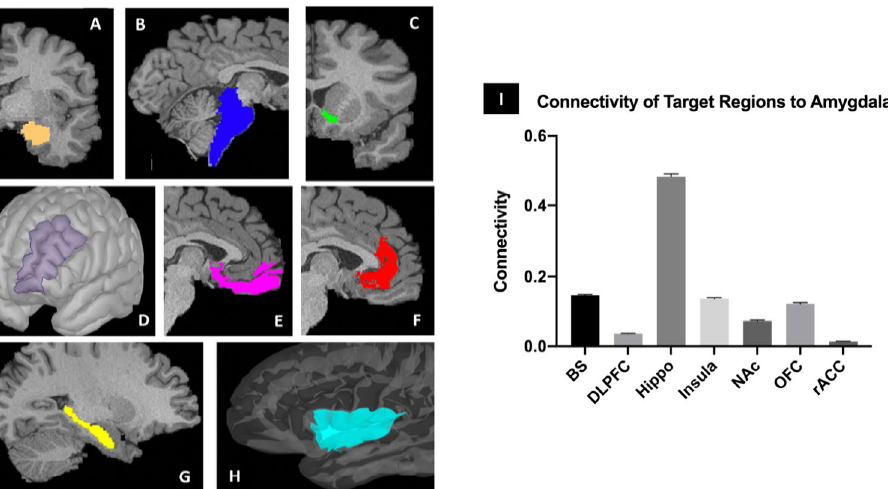
Figure 1. Cortical ( D , E , F , H ) and subcortical ( B , C , G ) masks of the target brain areas and the amygdala (A, center) from a single subject. ( A ): Amygdala. ( B ): Brainstem (BS). ( C ): Nucleus accumbens (NAc) ( D ): Dorsolateral prefrontal cortex (DLPFC). ( E ): Orbitofrontal cortex (OFC). ( F ): Rostral anterior cingulate cortex (rACC). ( G ): Hippocampus (Hippo). ( H ): Insula 30 . ( I ) Probability of connectivity from the amygdala to each target region. The connection probability of each voxel of the amygdala to each of the seven target regions was averaged over all amygdala voxels and this value then averaged across all subjects. Note that the highest probability of connectivity is to the hippocampus (48%). Thus, 48% of all streamlines from the amygdala to the above targets terminated in the hippocampus.